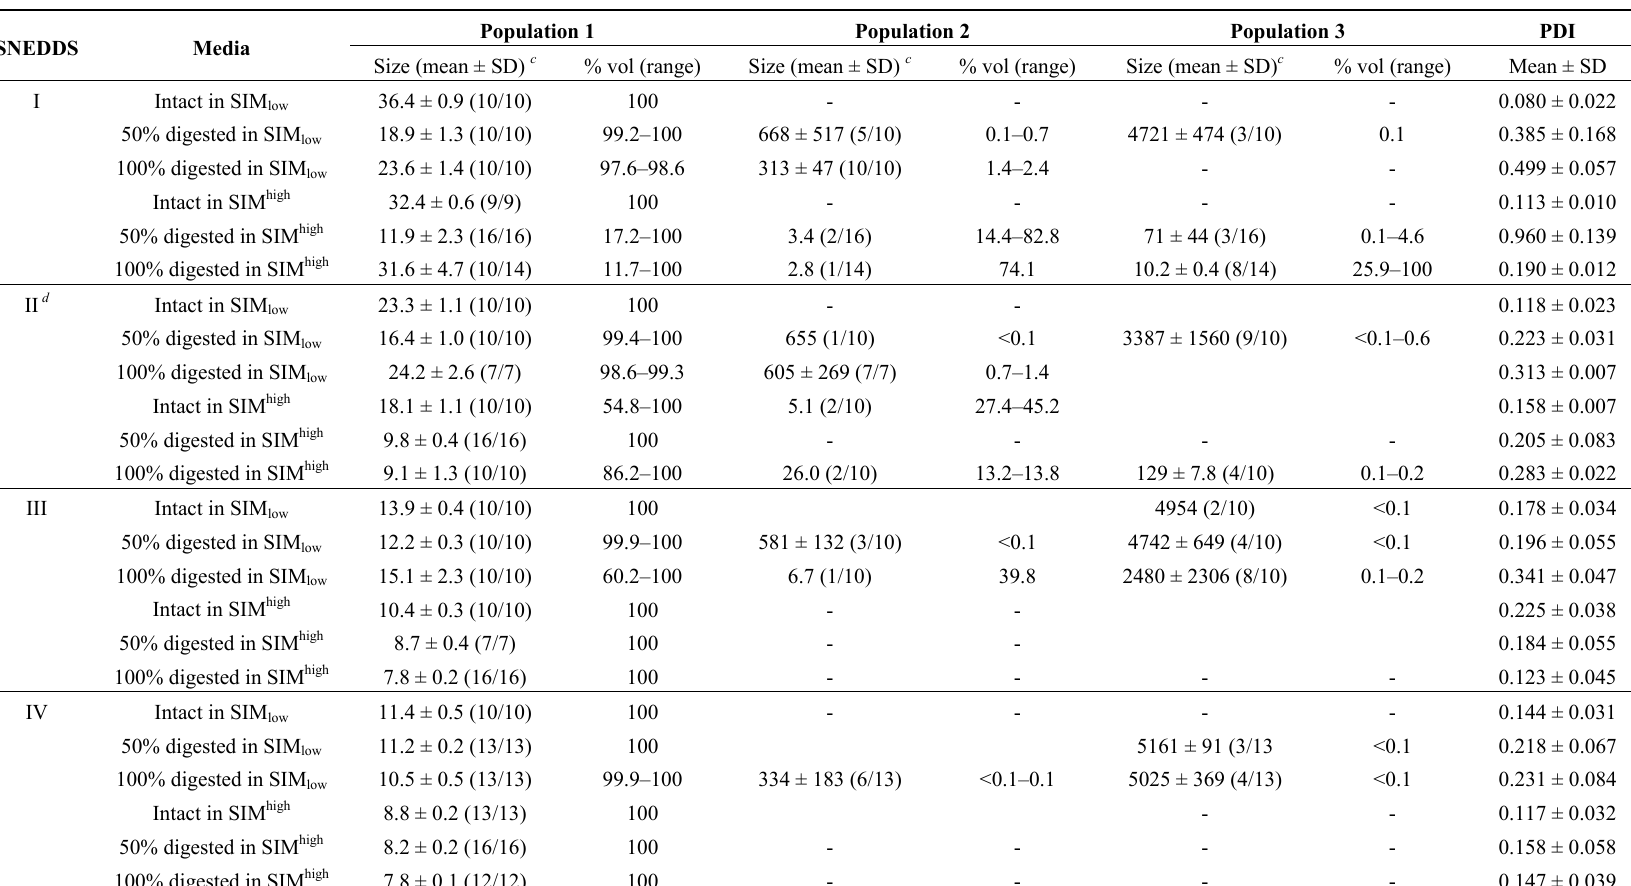
Table 7. Droplet sizes of dispersed intact SNEDDS and SNEDDS composed of 50% or 100% mimicked digested sesame oil in SIM (1% ( w / w ). The SNEDDSs and the mimicked digested SNEDDSs contained 25 mg cinnarizine per gram. Measurements were performed at 37 °C and the results are presented as the hydrodynamic diameter (nm) a , b